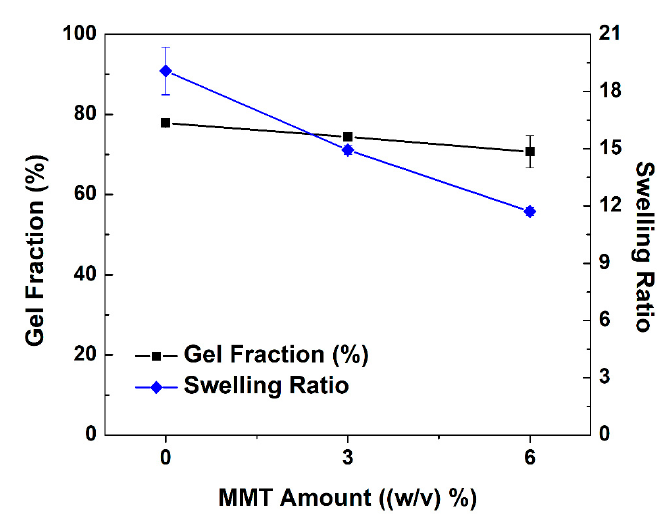
Figure 5. Weight swelling ratio with respect to dry state (q w ) and gel fraction (Wg) (%) of algi- nate/MMT composite cryogels as a function of MMT content (( w/v ) %). Measurements completed at least triplicate.